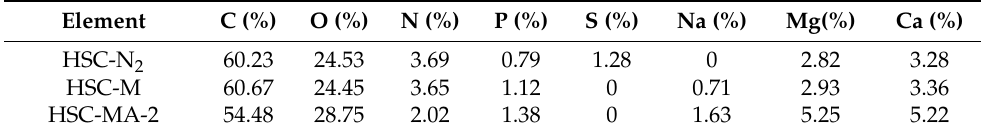
Figure 3. XPS image of the HSC-N 2 , HSC-M and HSC-MA-2 ( a ) full spectra, ( b ) C1s, ( c ) O1s, ( d ) N2p, ( e ) S2p, ( f ) P2p, ( g ) Na1s, ( h ) Mg1s, ( i ) Ca2p. Table 1. The element composition of the biochars measured by XPS.